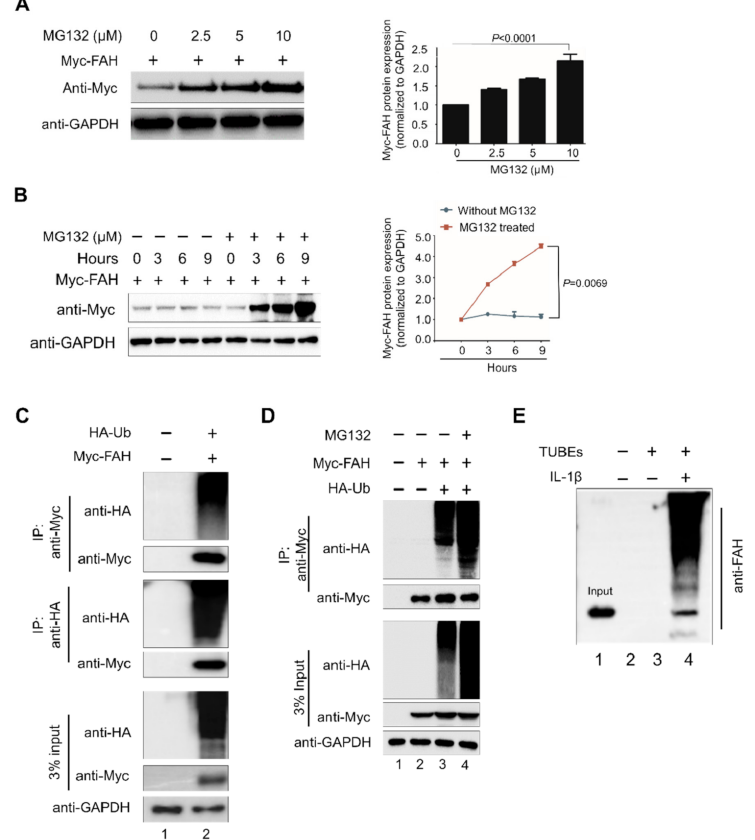
Figure 2. FAH undergoes proteolysis through 26S proteasomal pathway. ( A ) Exogenous Myc-FAH expression upon dose-dependent treatment of MG132 was determined in HEK293 cells through Western blot analysis with suitable antibodies. The Myc-FAH band intensity was estimated by ImageJ software and normalized with Glyceraldehyde 3-phosphase dehydrogenase (GAPDH) as control for graphical representation. Data were presented as the mean and standard deviation of three independent experiments. One-way ANOVA followed by Tukey’s post hoc test was used and p -values are indicated. ( B ) HEK293 cells were treated with dimethylsulfoxide as control or MG132 (7.5 µ M) to check the exogenous Myc-FAH expression through Western blot analysis. The Myc-FAH band intensity was estimated by ImageJ software and normalized with GAPDH for graphical representation. Two-way ANOVA followed by Tukey’s post hoc test was used and p -values are indicated. ( C ) Myc-FAH was transfected individually or with HA-ubiquitin into HEK293 cells for immunoprecipitation with Myc antibody followed by immunoblotting with HA or Myc antibody. Reciprocal immunoprecipitation was performed with HA antibody, followed by immunoblotting with HA or Myc antibody. ( D ) Myc-FAH was transfected with HA-ubiquitin and cells were treated with MG132 in HEK293 cells to evaluate the e ff ects on the ubiquitination and proteolysis of Myc-FAH. Cell lysates were immunoprecipitated with Myc antibody followed by immunoblotting with HA or Myc antibody. ( E ) Tandem Ubiquitin Binding Entities (TUBEs) assay for the ubiquitination of FAH proteins were conducted in Human hepatic stellate cells (HHSteCs) in the presence or absence of IL-1 β keeping only agarose beads as control. Cell lysates were immunoprecipitated with TUBE antibody followed by immunoblotting with specific anti-FAH antibody. Lane1 is Input, lane 2 is control only agarose beads, lane 3 (without IL-1 β ) IP with Tubes and immunoblot with anti-FAH antibody and lane 4 (with IL-1 β ) IP with Tubes and immunoblot with anti-FAH